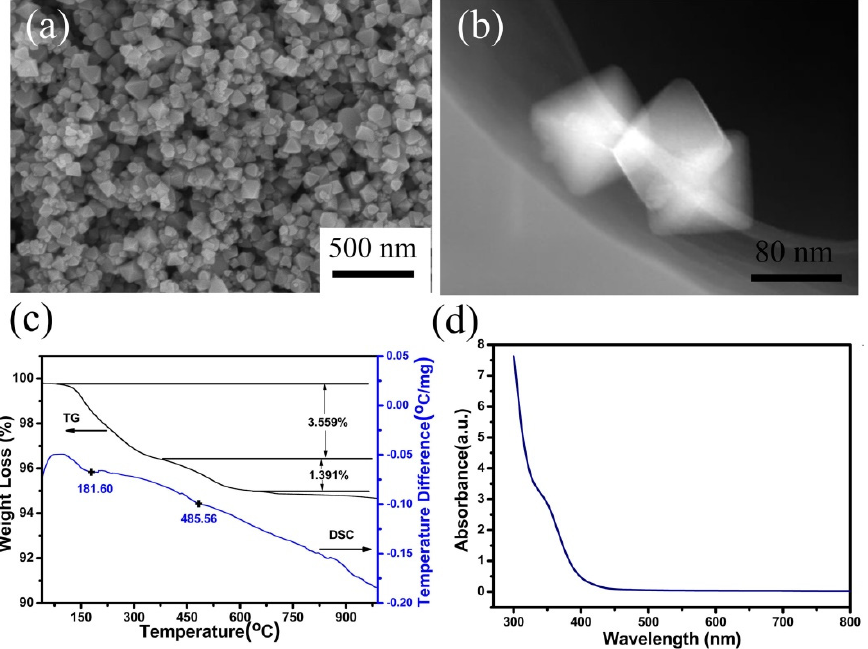
Figure 1. ( a ) SEM and ( b ) HAADF-STEM images, ( c ) TG-DSC curves and ( d ) UV-Vis absorption spectrum of the hydrothermally synthesized perovskite PbTiO 3 nanooctahedron crystals.